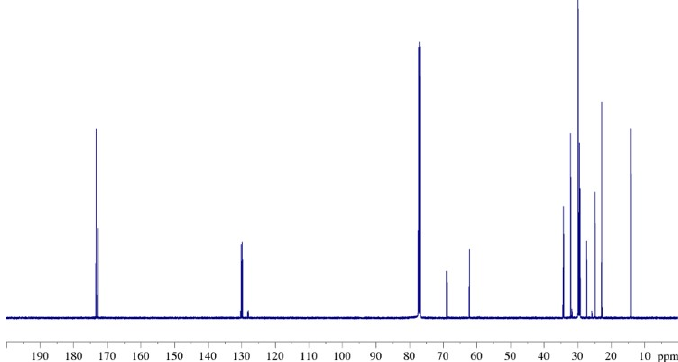
Figure 9. 13 C NMR spectrum (125 MHz, 298 K, in CDCl 3 ) of natural CB (sample